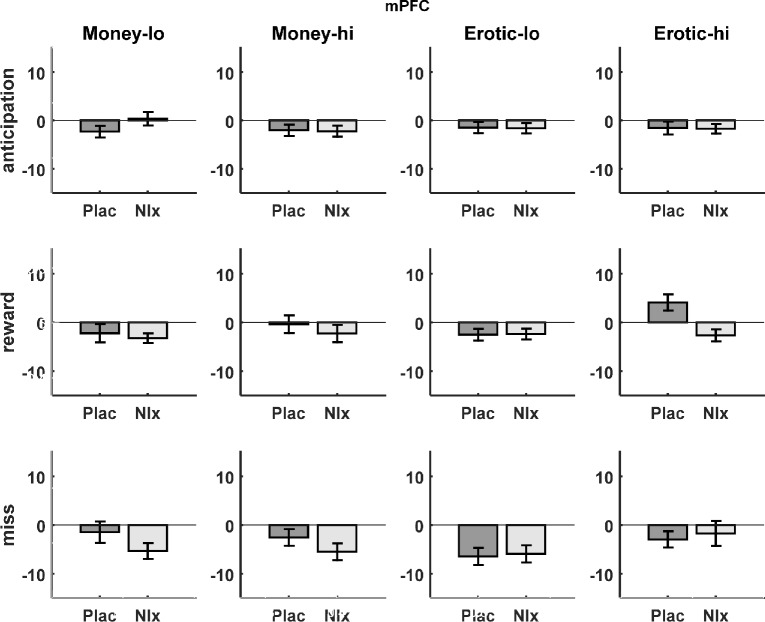
Medial prefrontal cortex fMRI responses (arbitrary units) for all stimuli (money/erotic, high/low) and time-points (anticipation, outcome: reward, outcome: miss) under placebo (Plac) and naloxone (Nlx).Error bars represent standard error of the mean.